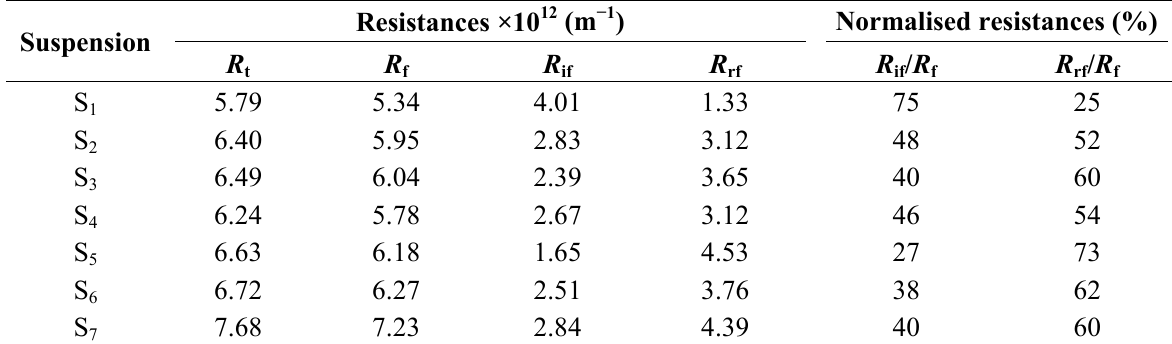
Table 2. Values of resistances obtained from the microfiltration of tested cell suspensions.